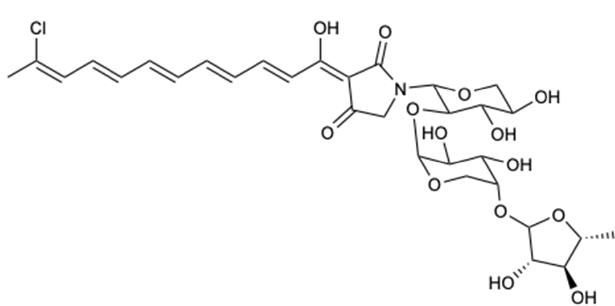
Figure 3. Structure of aurantosides G–J ( 1 – 4 ).